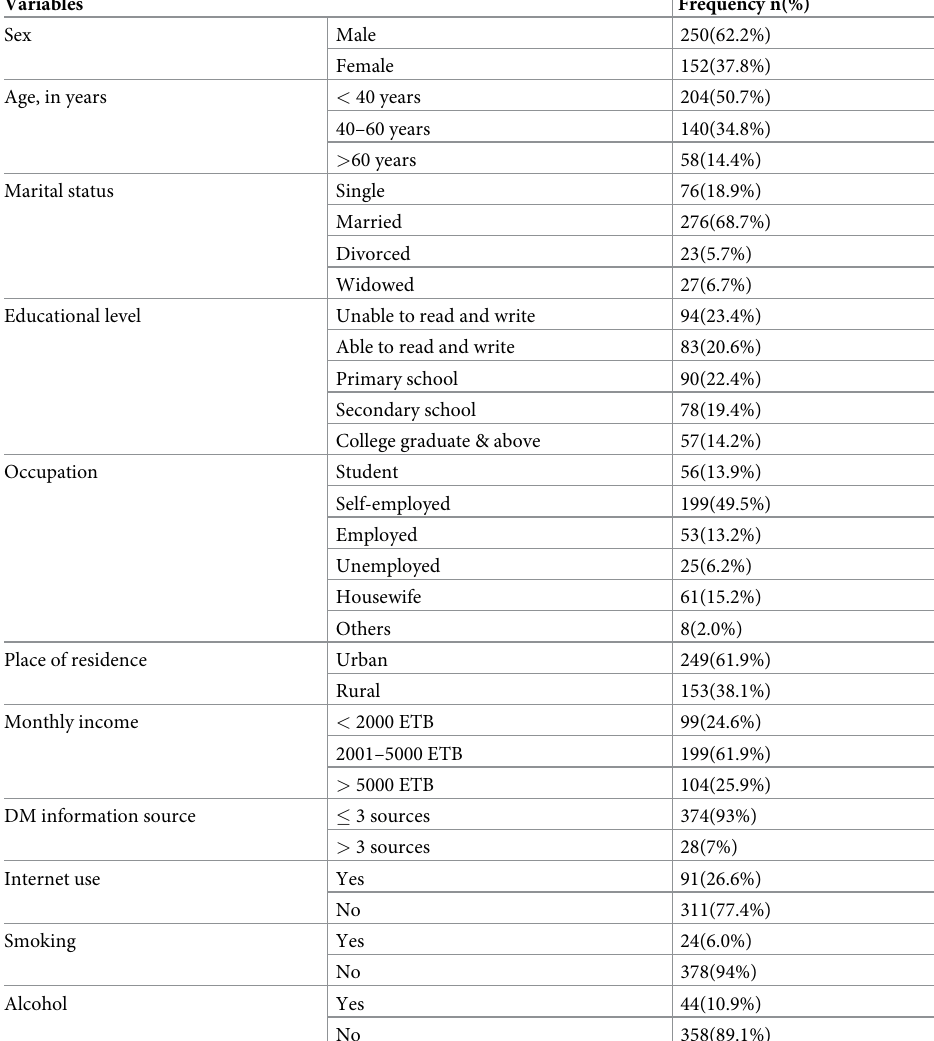
Table 1. Socio-demographic characteristics of diabetic patients at the outpatient clinic of public hospitals, Bale Zone, 2021(n = 402).